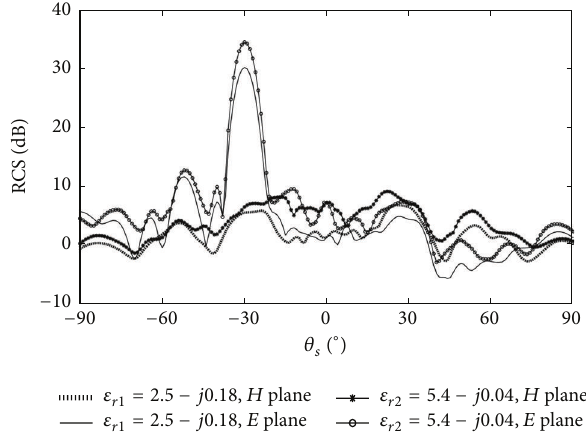
Figure 8: The relative permittivity of sphere is 𝜀 𝑟,𝑡 = 2 − 𝑗3 , the relative permittivity of rough surface is 𝜀 𝑟1 = 2.5 − 𝑗0.18 , 𝜀 𝑟2 = 5.4 − 𝑗0.04 , bistatic RCS from composite model of dielectric sphere and rough surface (30 average statistics